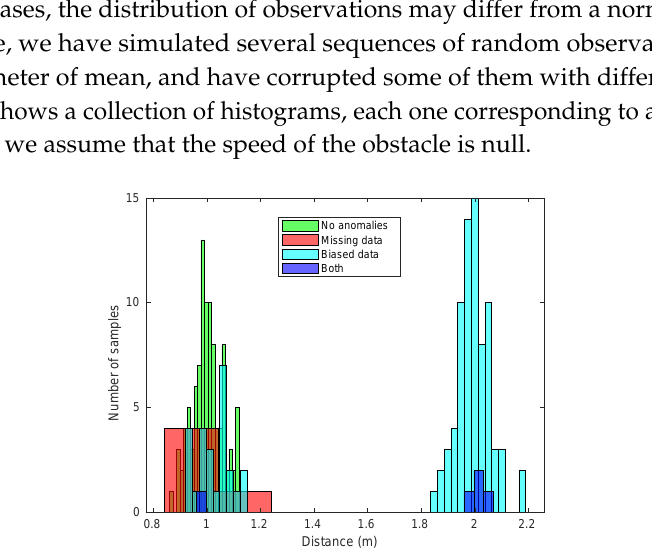
Figure 4. Histograms for sequences of range observation data. These sequences have been obtained from a normal distribution with 1 me of mean; some of them have been corrupted with different combinations of